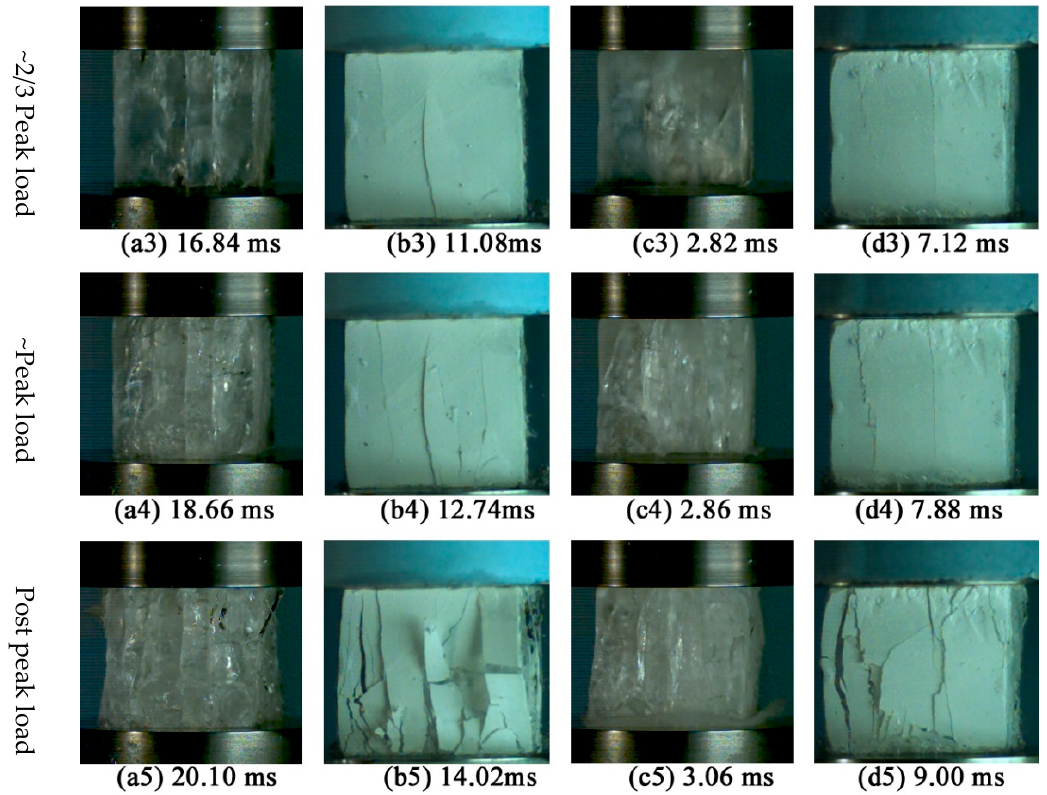
Figure 9. Failure processes of hard ice at moderate rates: ( a , b ) the horizontal loading failure processes of hard ice; and ( c , d ) the vertical loading failure processes of hard ice. The recording rate of high-speed camera is 50,000 fps.